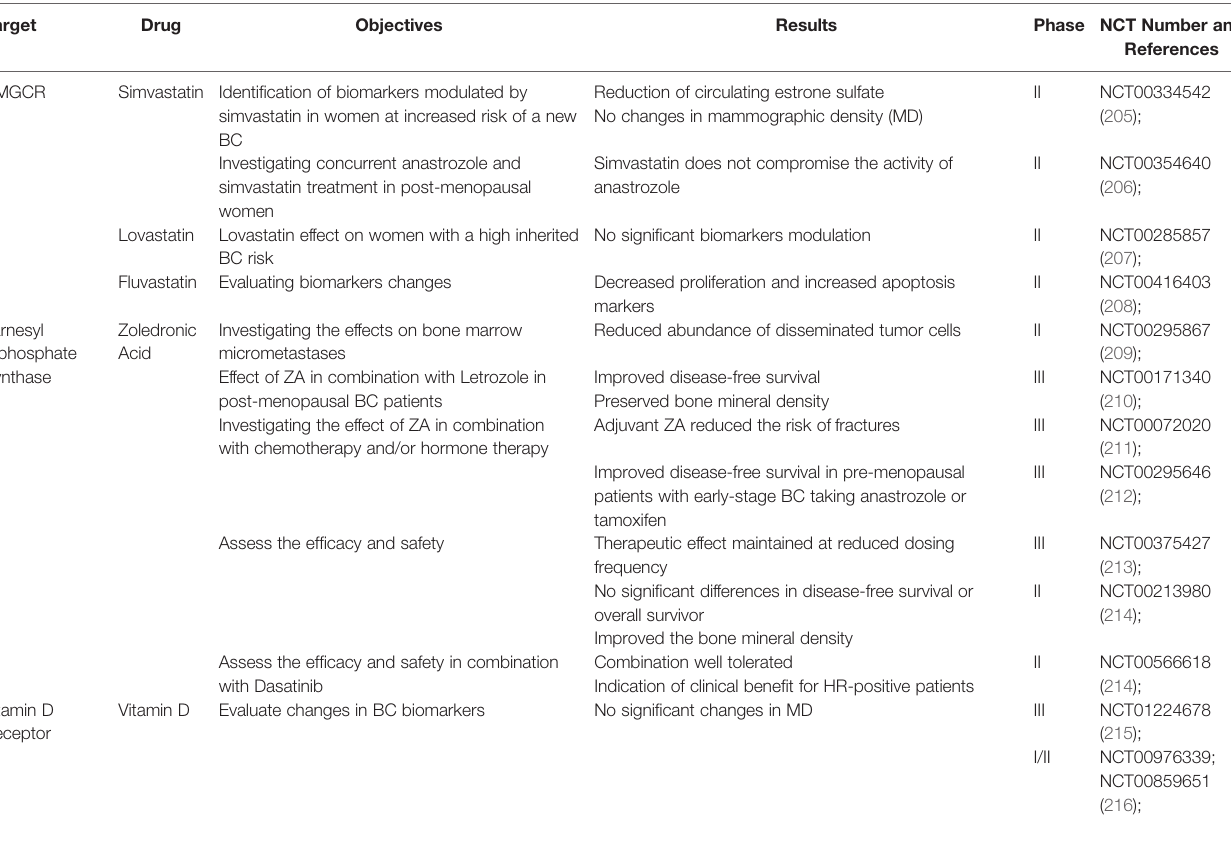
TABLE 1 | A list of completed interventional studies with published results that assess the bene fi cial role of cholesterol-lowering drugs and vitamin D in BC